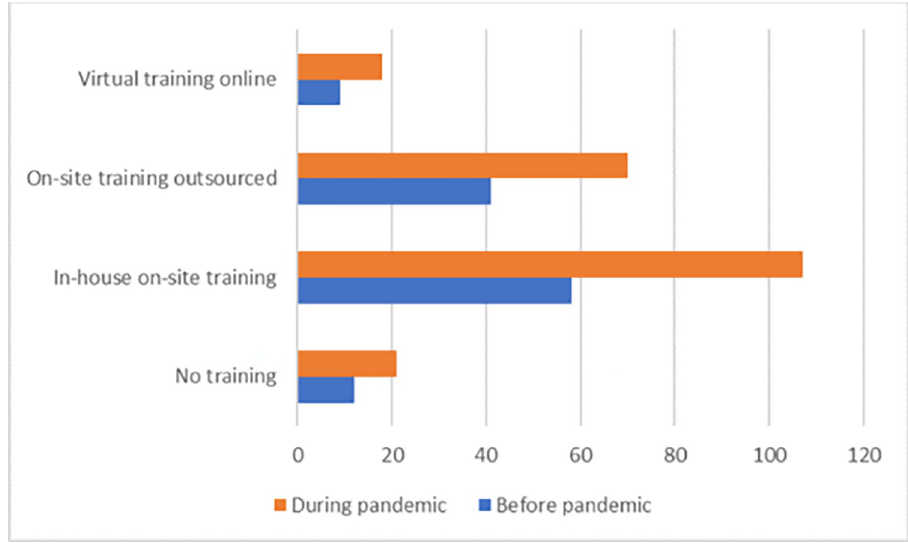
Fig 5. Risk prevention training. Source: By the authors.